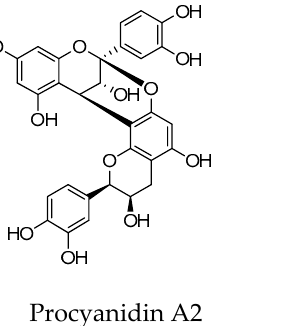
Figure 1. Structures of A-type proanthocyanidins found in cranberry.